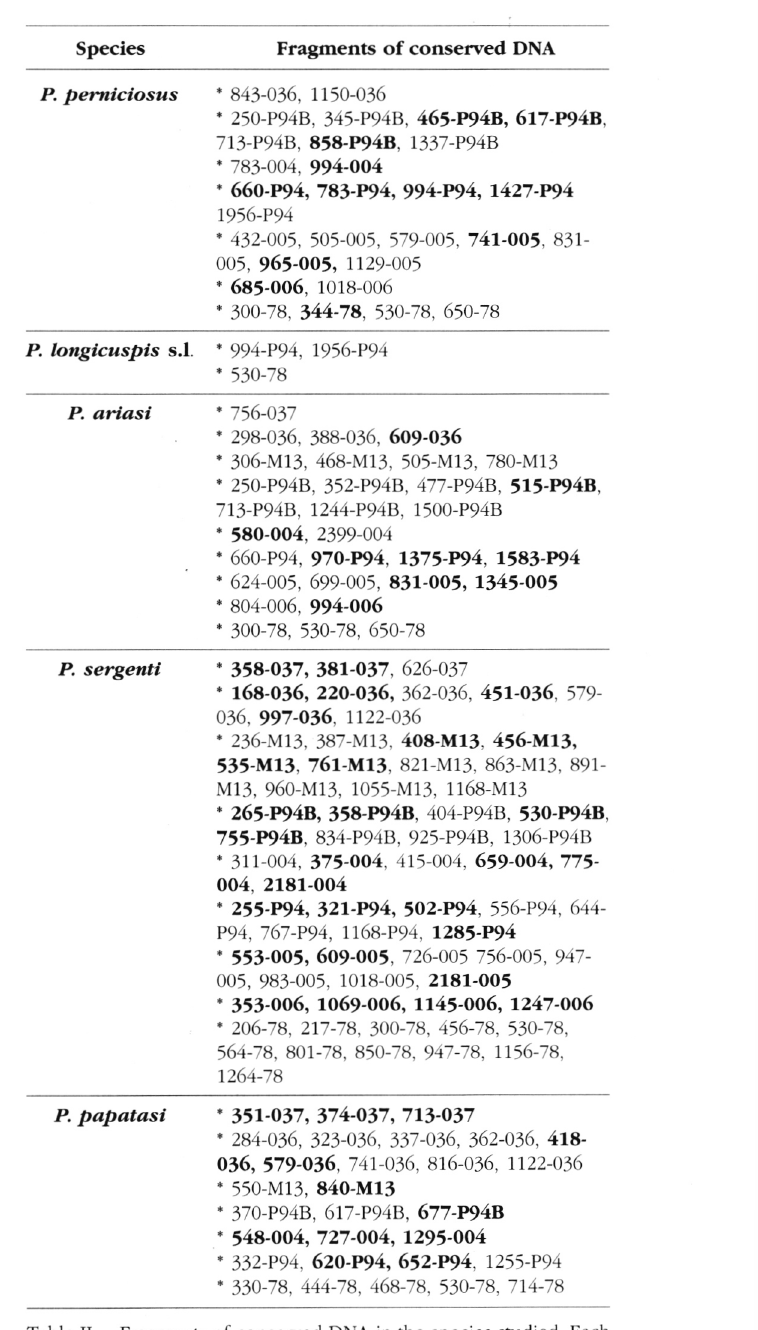
Table II. - Fragments of conserved DNA in the species studied. Each fragment is denominated by its Molecular weight in base pairs fol­ lowed by the name of the primer used. The most easily identifiable fragments, in general of the greatest intensity and, preferentially, not shared by other species, are marked in